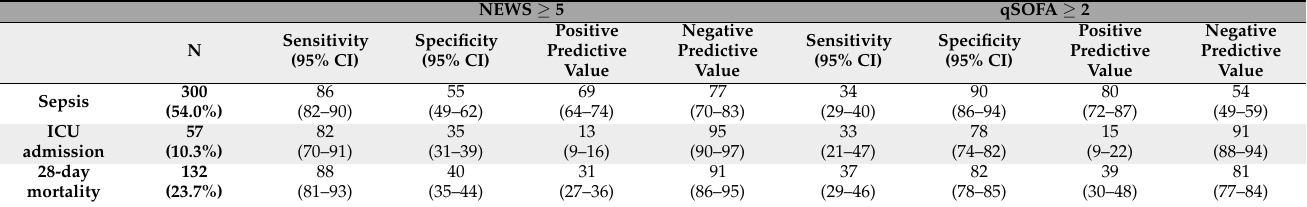
Table 1. Sensitivity, specificity, positive and negative predictive values of NEWS and qSOFA for sepsis detection, ICU admission, and 28-day